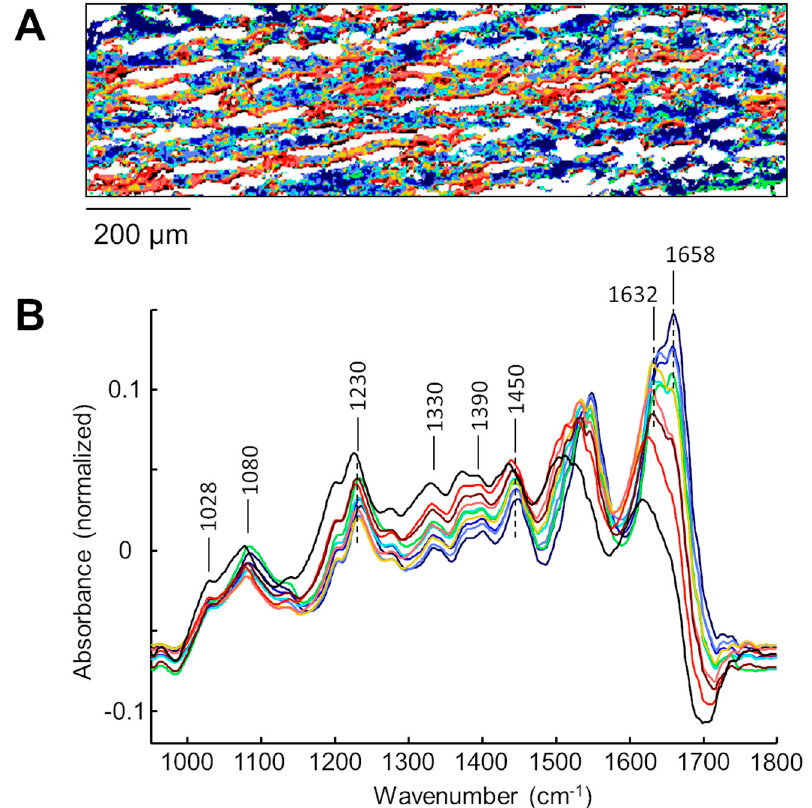
Figure 7. Results of k-means cluster analysis of the spectroscopic data set registrated from the non-implanted prosthesis sample. A ) assignment of clusters. B ) corresponding cluster centroid spectra.